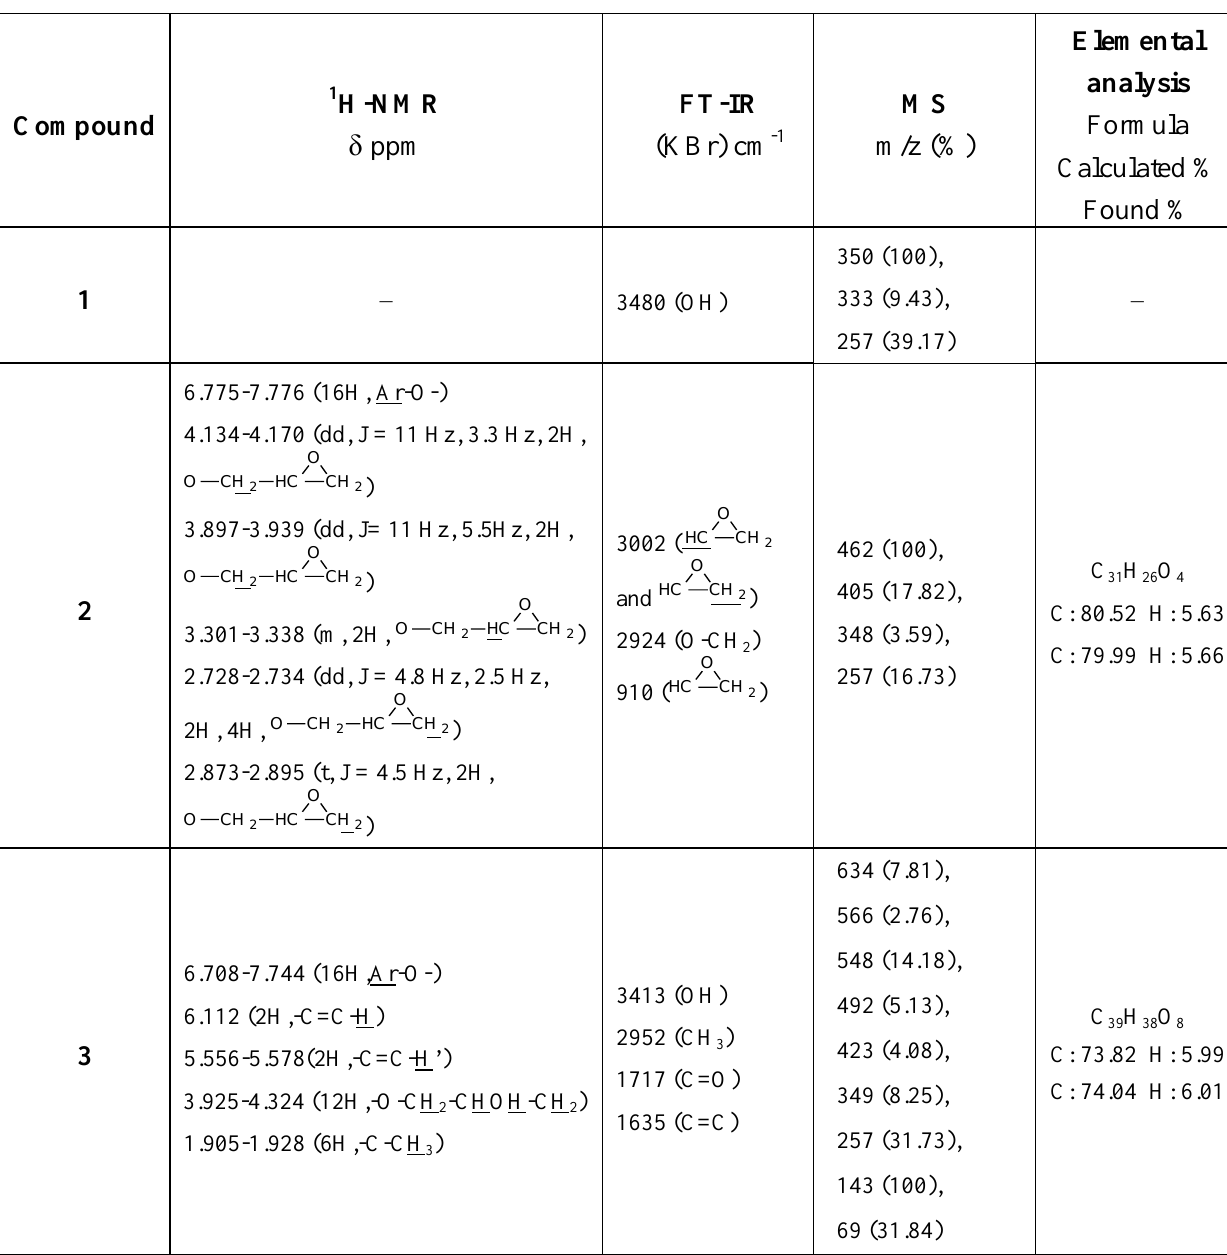
Table 1. Spectral and elemental analysis data for 1 -